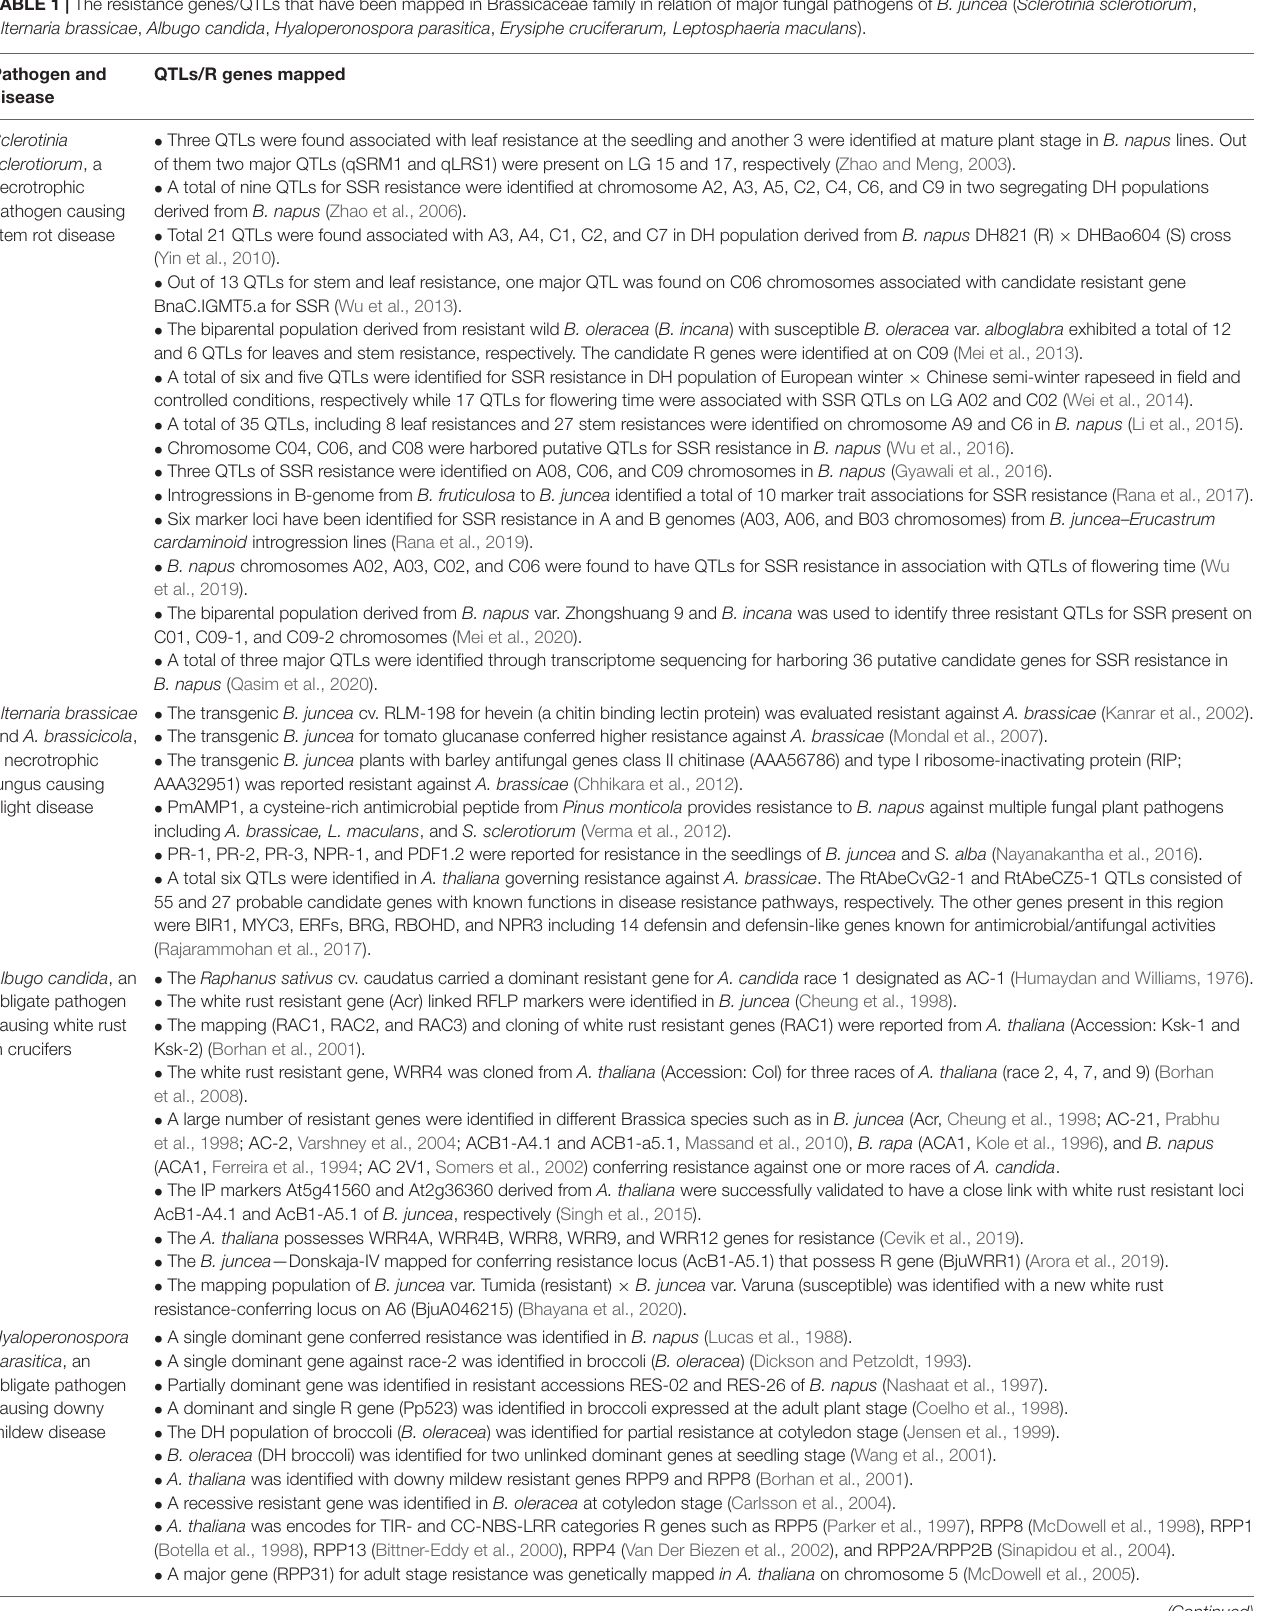
TABLE 1 | The resistance genes/QTLs that have been mapped in Brassicaceae family in relation of major fungal pathogens of B. juncea ( Sclerotinia sclerotiorum , Alternaria brassicae , Albugo candida , Hyaloperonospora parasitica , Erysiphe cruciferarum, Leptosphaeria maculans ). Pathogen and QTLs/R genes disease